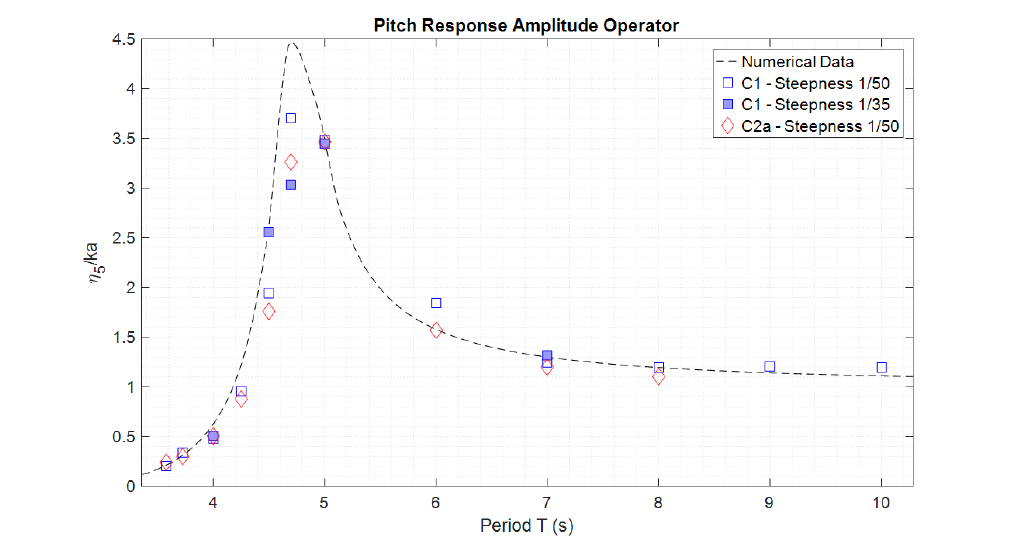
Figure 13. Experimental pitch RAOs compared with the free-floating pitch numerical